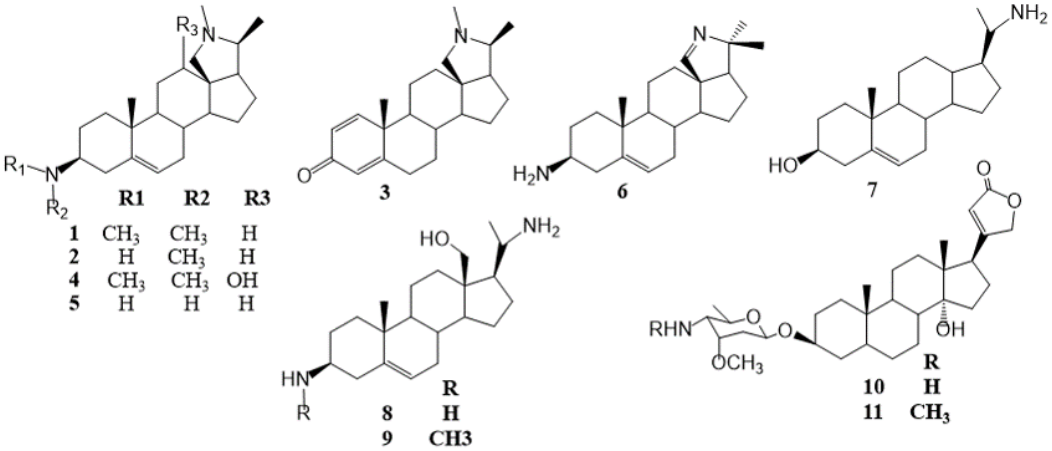
Figure 1: Chemical structures of alkaloids isolated from Holarrhena